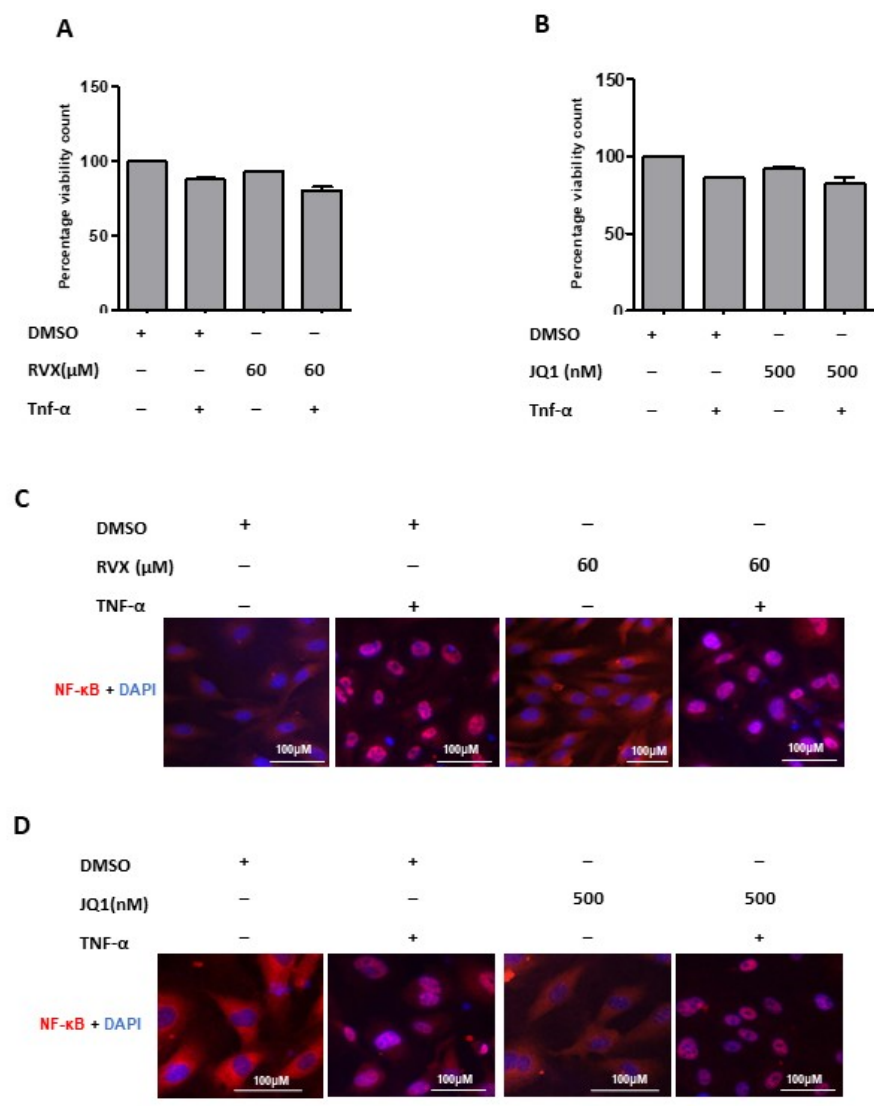
Figure 5. BRD4 inhibitors efficacy. ( A ) Cell viability assay; the bar graph shows percentage cell viability count in treatments with JQ1 after 12 h treatments. ( B ) bar graph shows percentage cell viability count in treatments with RVX208 after 12 h treatments. Inhibition of BRD4 function and target genes expression ( C , D ) Immunofluorescence images for the effect of RVX208 and JQ1 on cellular localization of NF ‐κ B in response to indicated treatments. HUVECs are stained with anti ‐ NF ‐κ B antibody (red) and DAPI (blue). Two ‐ way ANOVA with Bonferroni’s post ‐ test used. Values are mean ± SD of three biological.